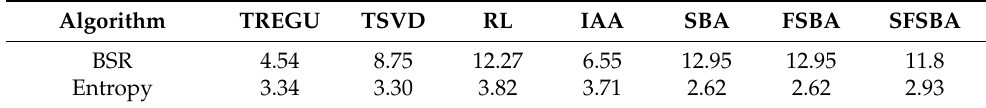
Table 7. Performance indexes of roof real